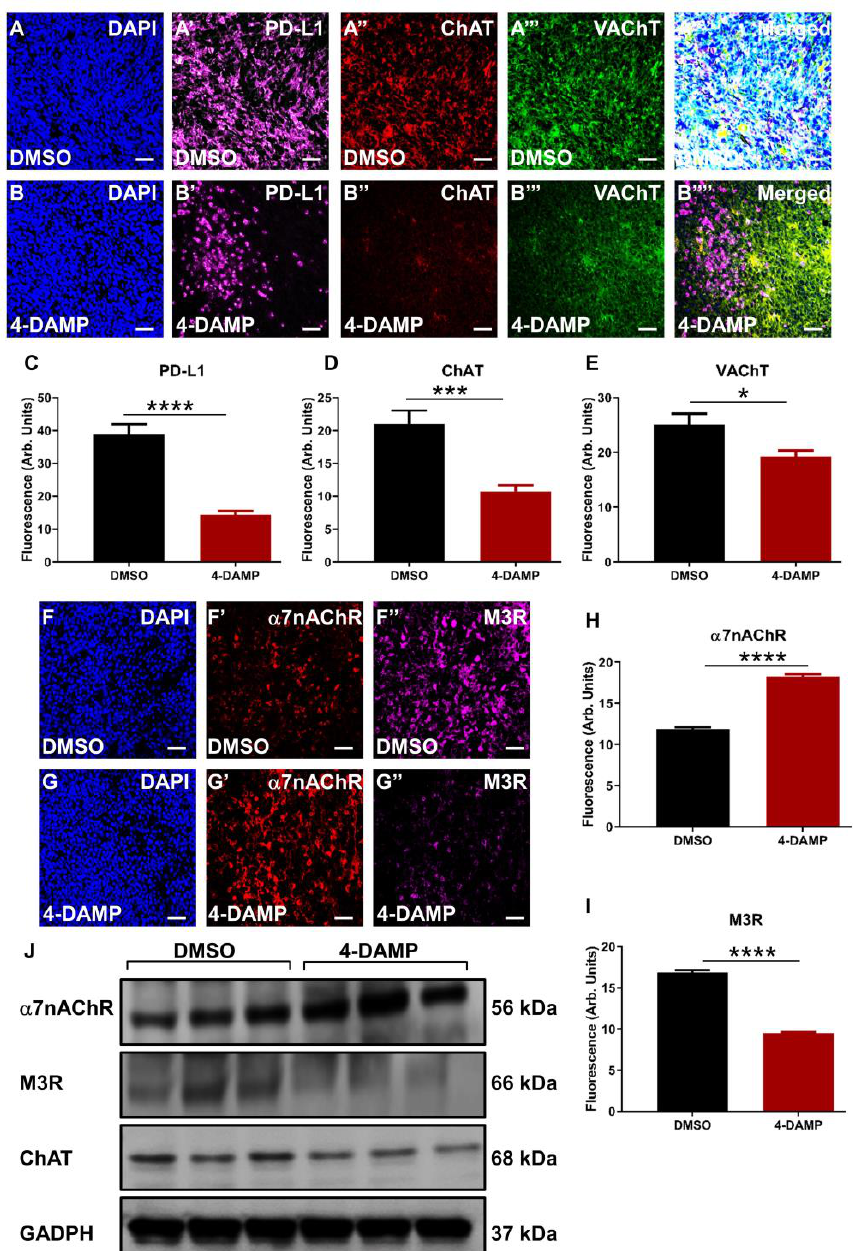
Figure 6. Correlation of PD-L1 expression with cholinergic markers in tumor samples from mice bearing CT-26 cell-induced tumors. Expression of PD-L1 and cholinergic markers (ChAT and VAChT) in tumor samples from mice bearing CT-26 cell-induced CRC treated with DMSO ( A – A’’’’ ) and 4-DAMP ( B – B’’’’ ). Tumors were labeled with the nuclei marker DAPI (blue; A-B), PD-L1 (magenta; A’ - B’), ChAT (red; A’’ , B’’ ), VAChT (green; A’’’ , B’’’ ), and all markers merged ( A’’’’ , B’’’’ ). Bar graphs displaying the mean fluorescence of PD-L1 ( C ), ChAT ( D ), and VAChT ( E ) in tumor samples from DMSO-treated and 4-DAMP-treated mice. Expression of cholinergic markers in tumor samples from mice bearing CT-26 cell-induced CRC treated with DMSO ( F – F’’ ) and 4-DAMP ( G – G’’ ). Tumors were labeled with the nuclei marker DAPI (blue; F , G ), α 7nAChR (red; F’ , G’ ), and M3R (magenta; F’’ , G ’’ ). Bar graphs displaying the mean fluorescence of α 7nAChR ( H ), M3R ( I ), and Western blot bands ( J ) in tumor samples from DMSO-treated and 4-DAMP-treated mice. The scale bar represents 50 µm. Data presented as mean ± SEM, n = 8 mice per group. Student’s t- test , * p < 0.05, *** p < 0.001, **** p < 0.0001.